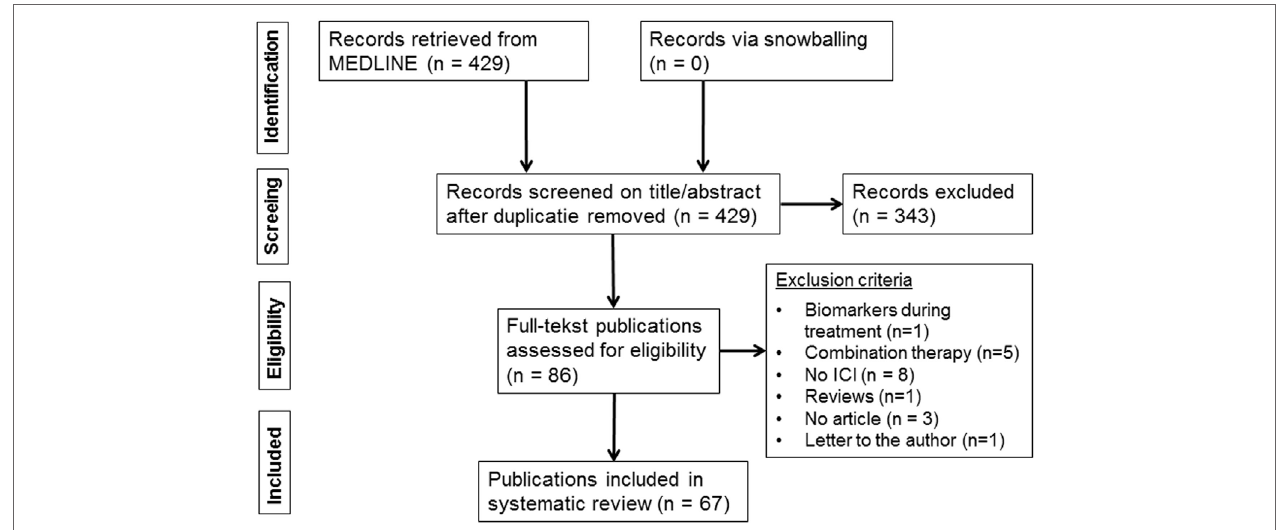
FiGURe 1 | Flow diagram of included